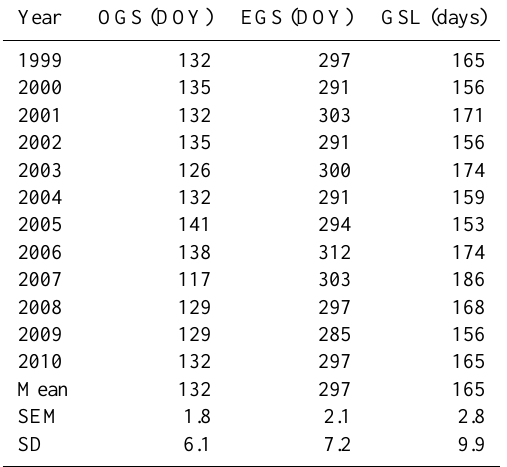
Table 4. Onset of growing season (OGS), end of growing season (EGS) and growing season length (GSL) defined by the start and end of net CO 2 uptake, at the Straits Inclosure, Alice Holt